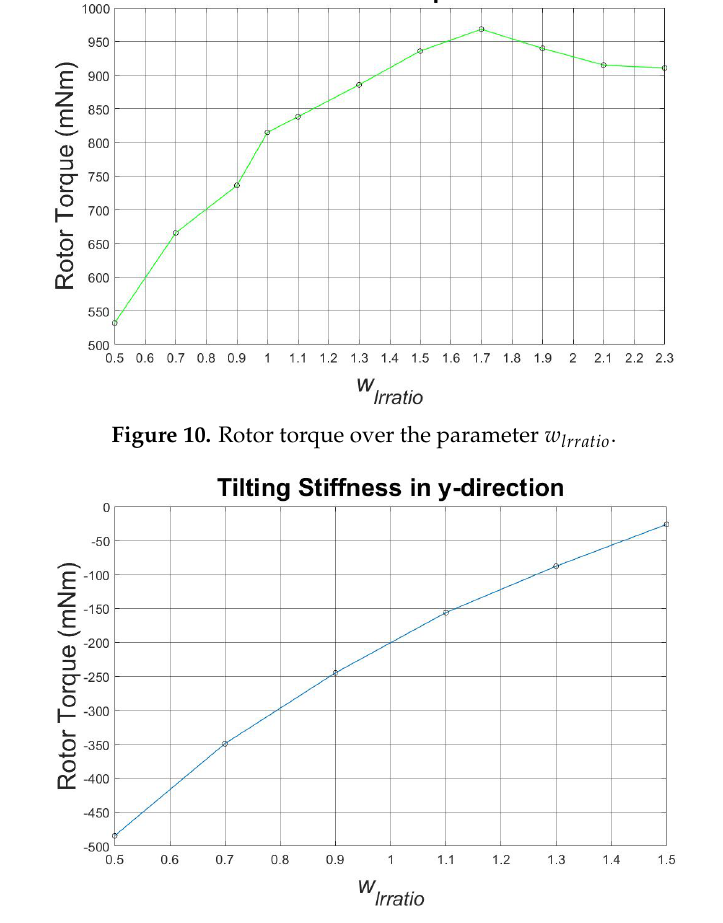
Figure 11. Tilting stiffness in the y-direction over the parameter w lrratio